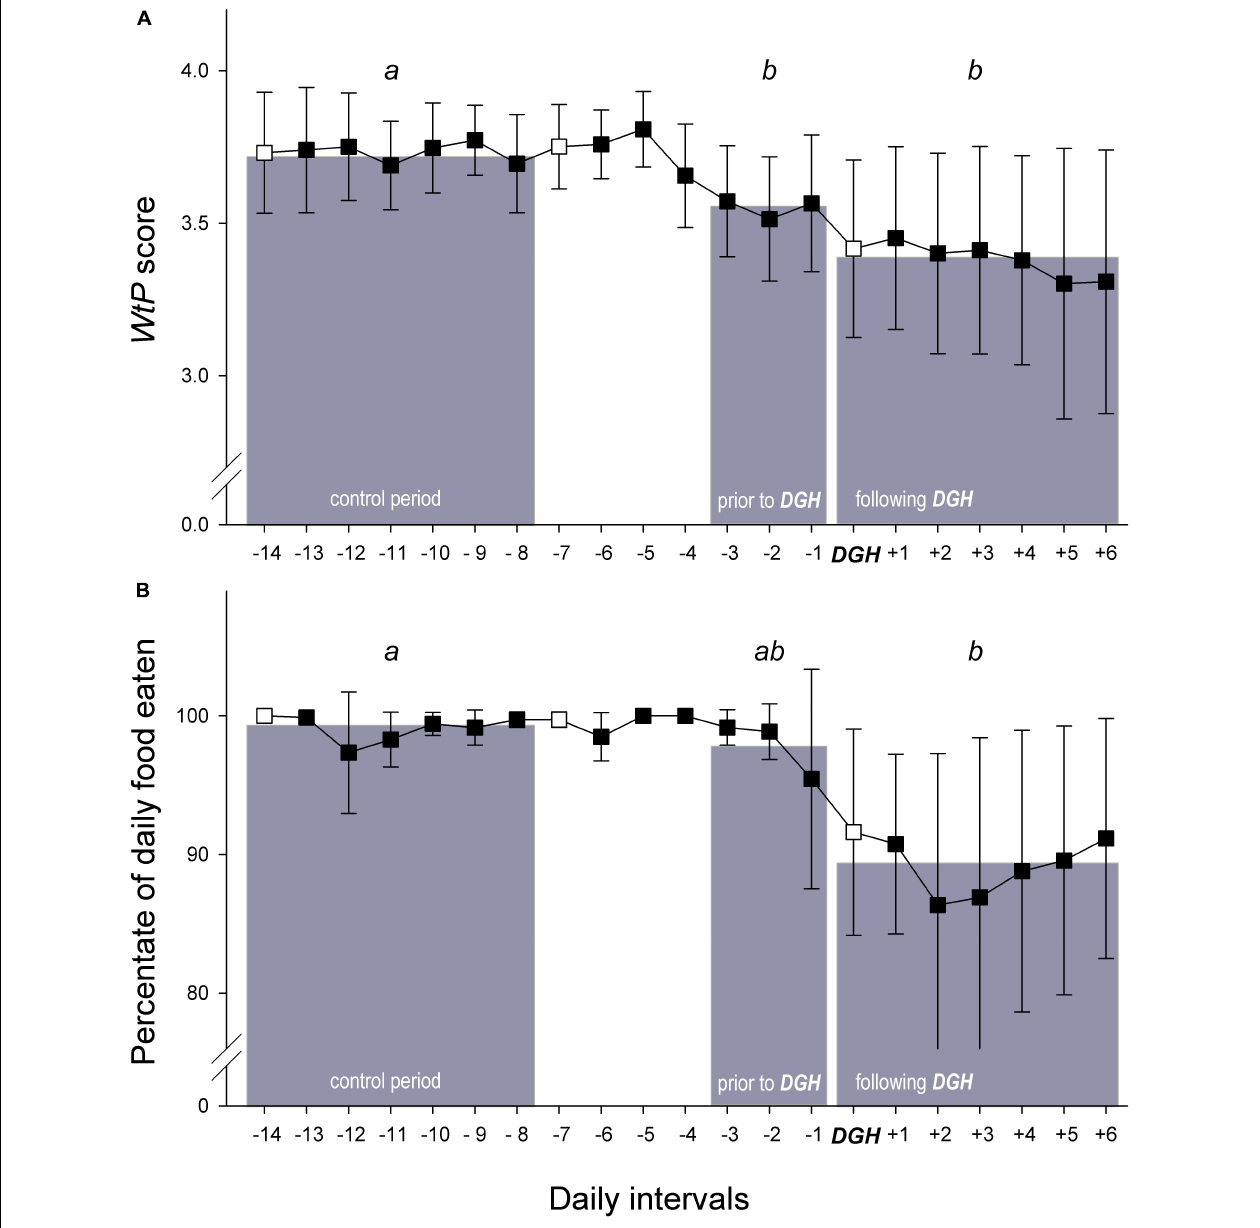
FIGURE 4 | Changes across time in (A) the WtP score (reflecting the dolphin’s willingness to participate in Positive Reinforcement Training) and (B) the percentage of daily food eaten before and after a departure from good health (‘DGH’) in the dolphins ( N = 26 individuals) was diagnosed during the weekly visit of the facilities’ veterinarians, defined as a decrease of the Health score from 0 to 1 ( N = 22 individuals) or from 0 directly to 2 ( N = 4 individuals). The days of the veterinarians’ weekly visits are indicated by an empty circle. Grey bars in background show the mean values of the different time periods, on which the statistical comparisons were based; see text for details. Statistically significant differences between the three periods are highlighted by different letters (Bonferroni-corrected comparisons post hoc to LMM with parametric bootstrapping, see text for